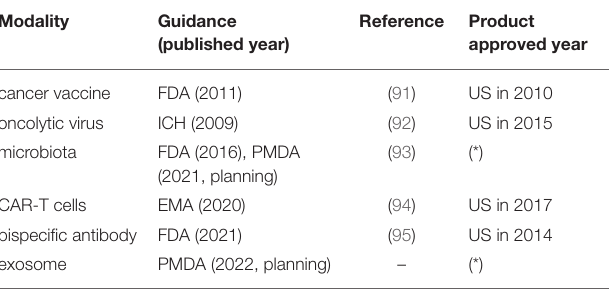
TABLE 3 | Guidance issued for cutting-edge